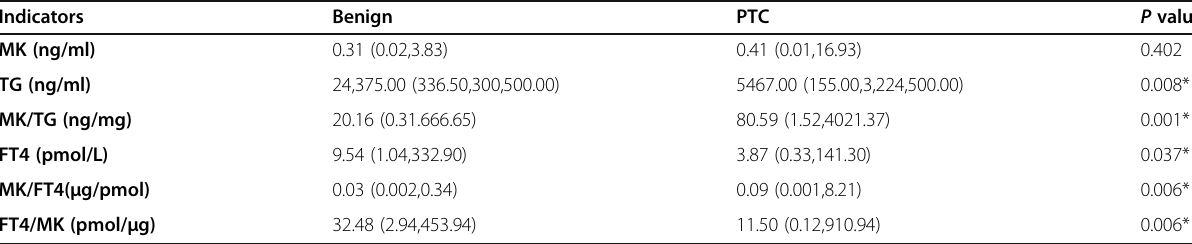
Table 2 MK ratios in benign versus malignant thyroid nodules Indicators Benign